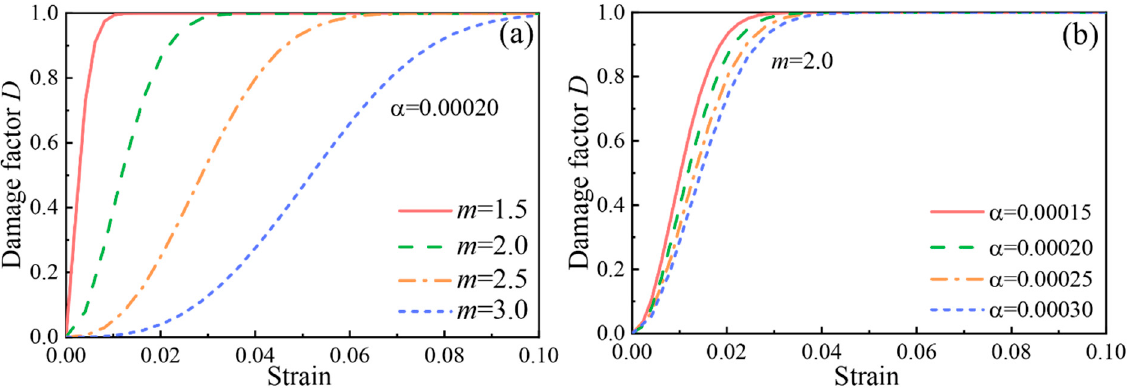
α α on damage factors: ( a ) as a fixed value and ( b ) m as a